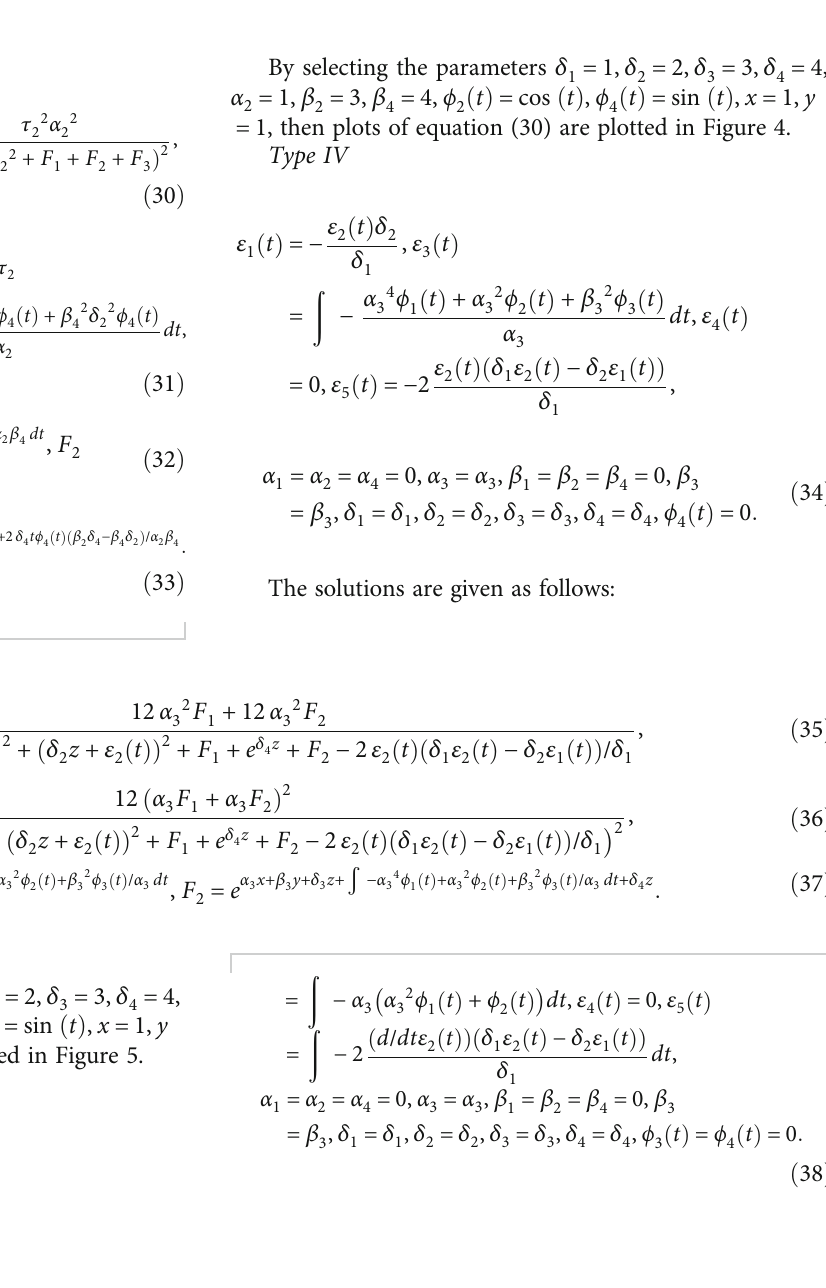
Figure 3: Plots of interaction lump with two solitons